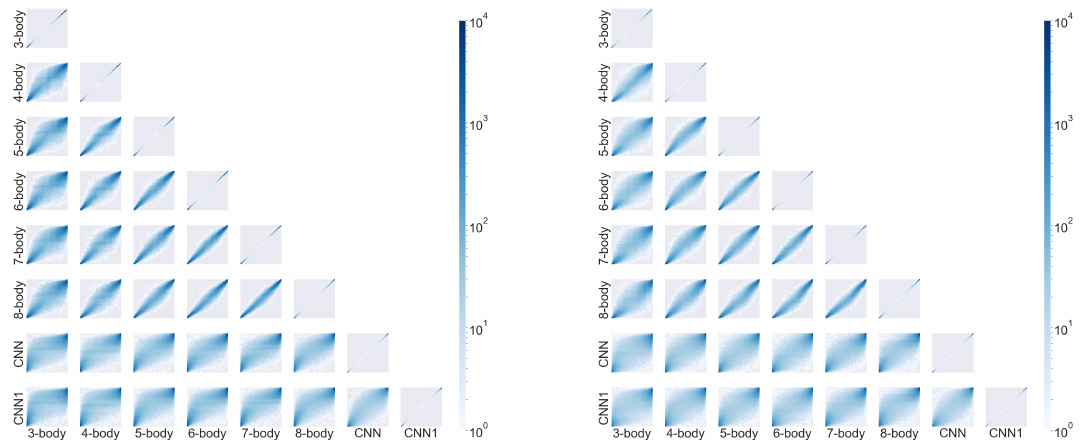
Figure 7: Correlation plots for top quark tagging without mass on the left and with ∈ [ 350,400 ] GeV. There are strong correlations between n - mass on the right, for p T subjettiness variables in different m -body phase space. Adding mass to the network increases the spread of the correlation in the image networks.